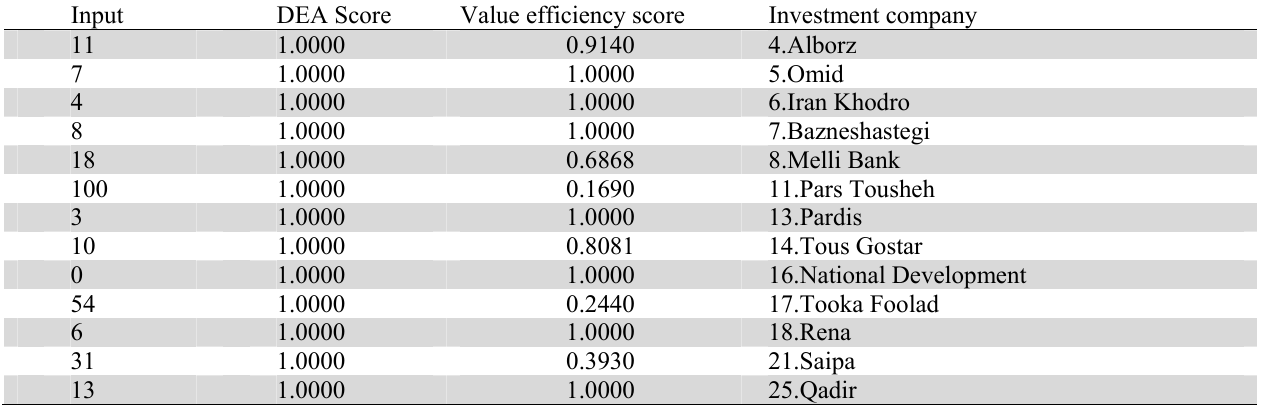
Efficient investment